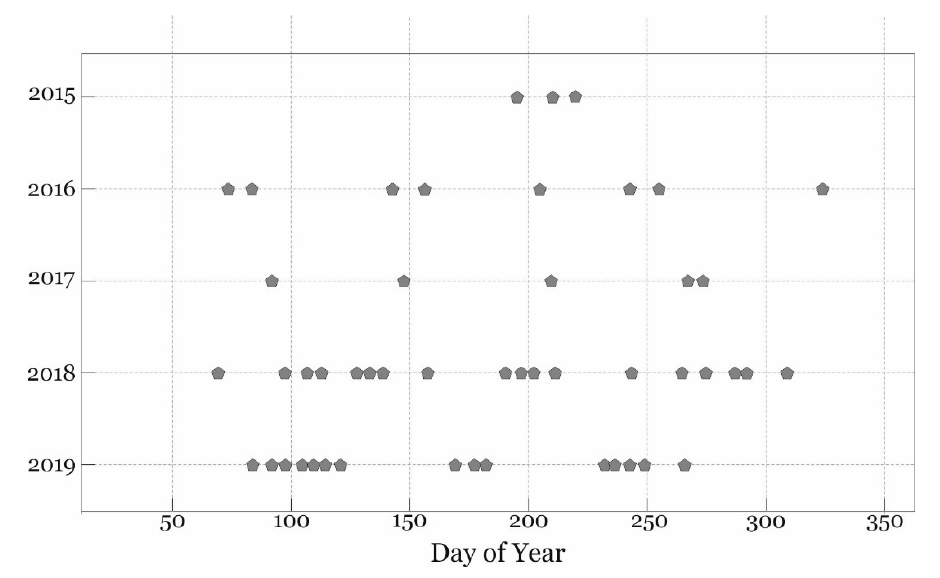
Figure 2. Acquisition dates of the Sentinel-2 time series used in this study.